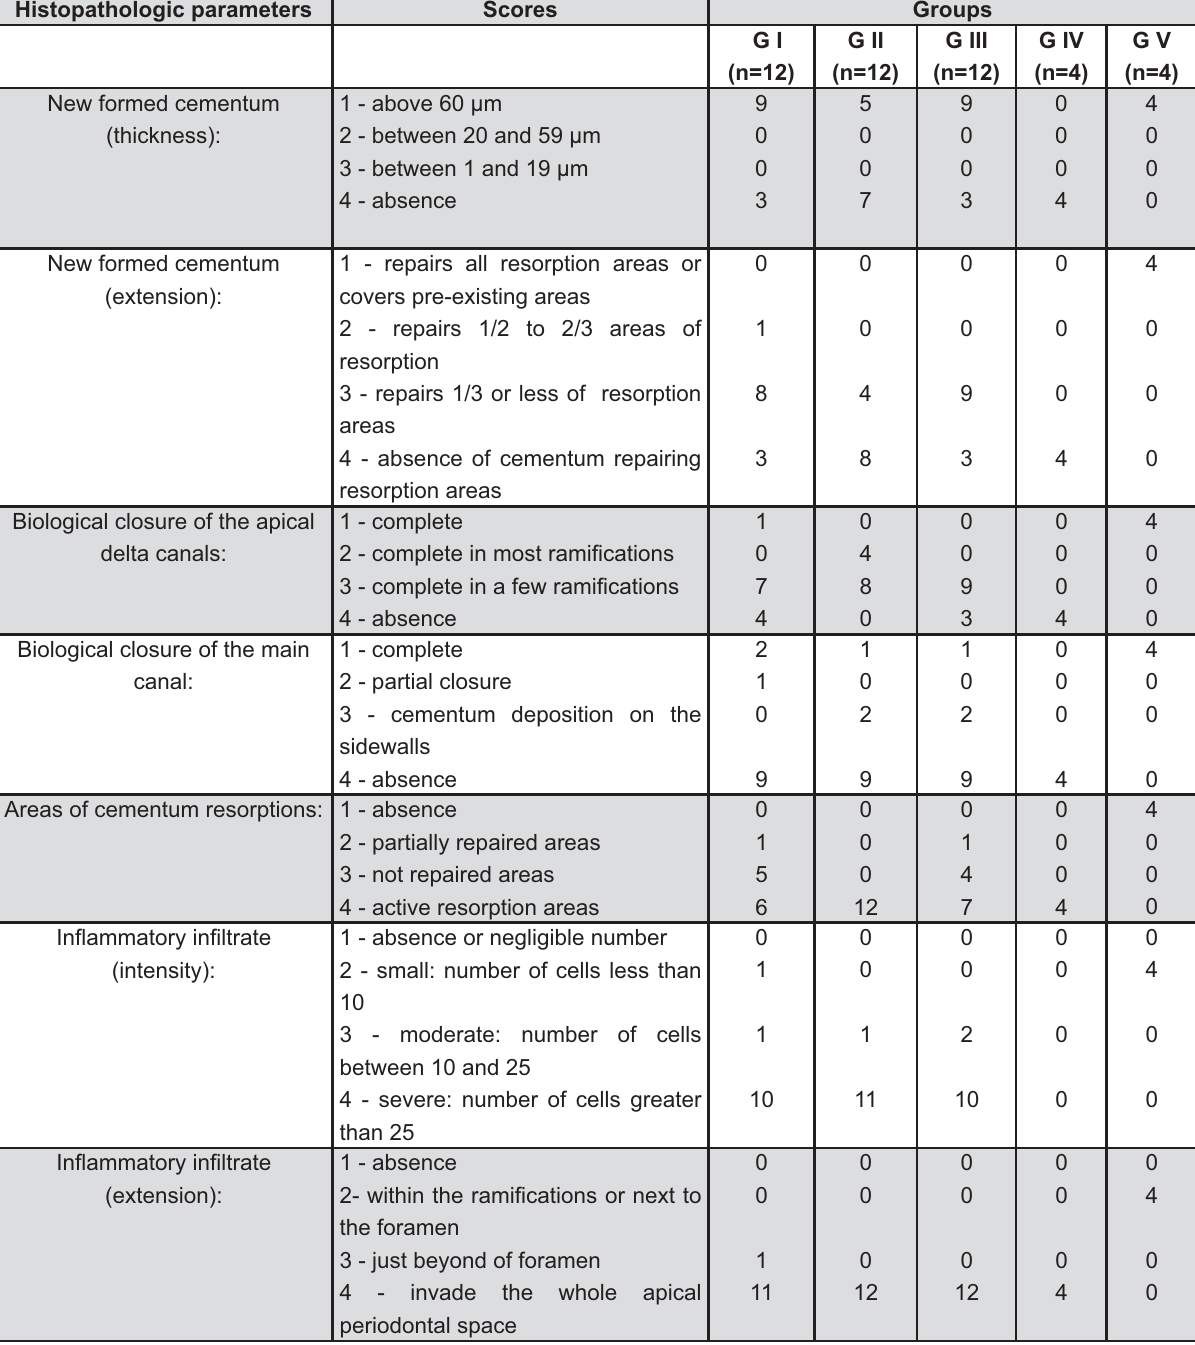
Figure 6- Distribution of specimens of each group according to scores of histopathologic parameters